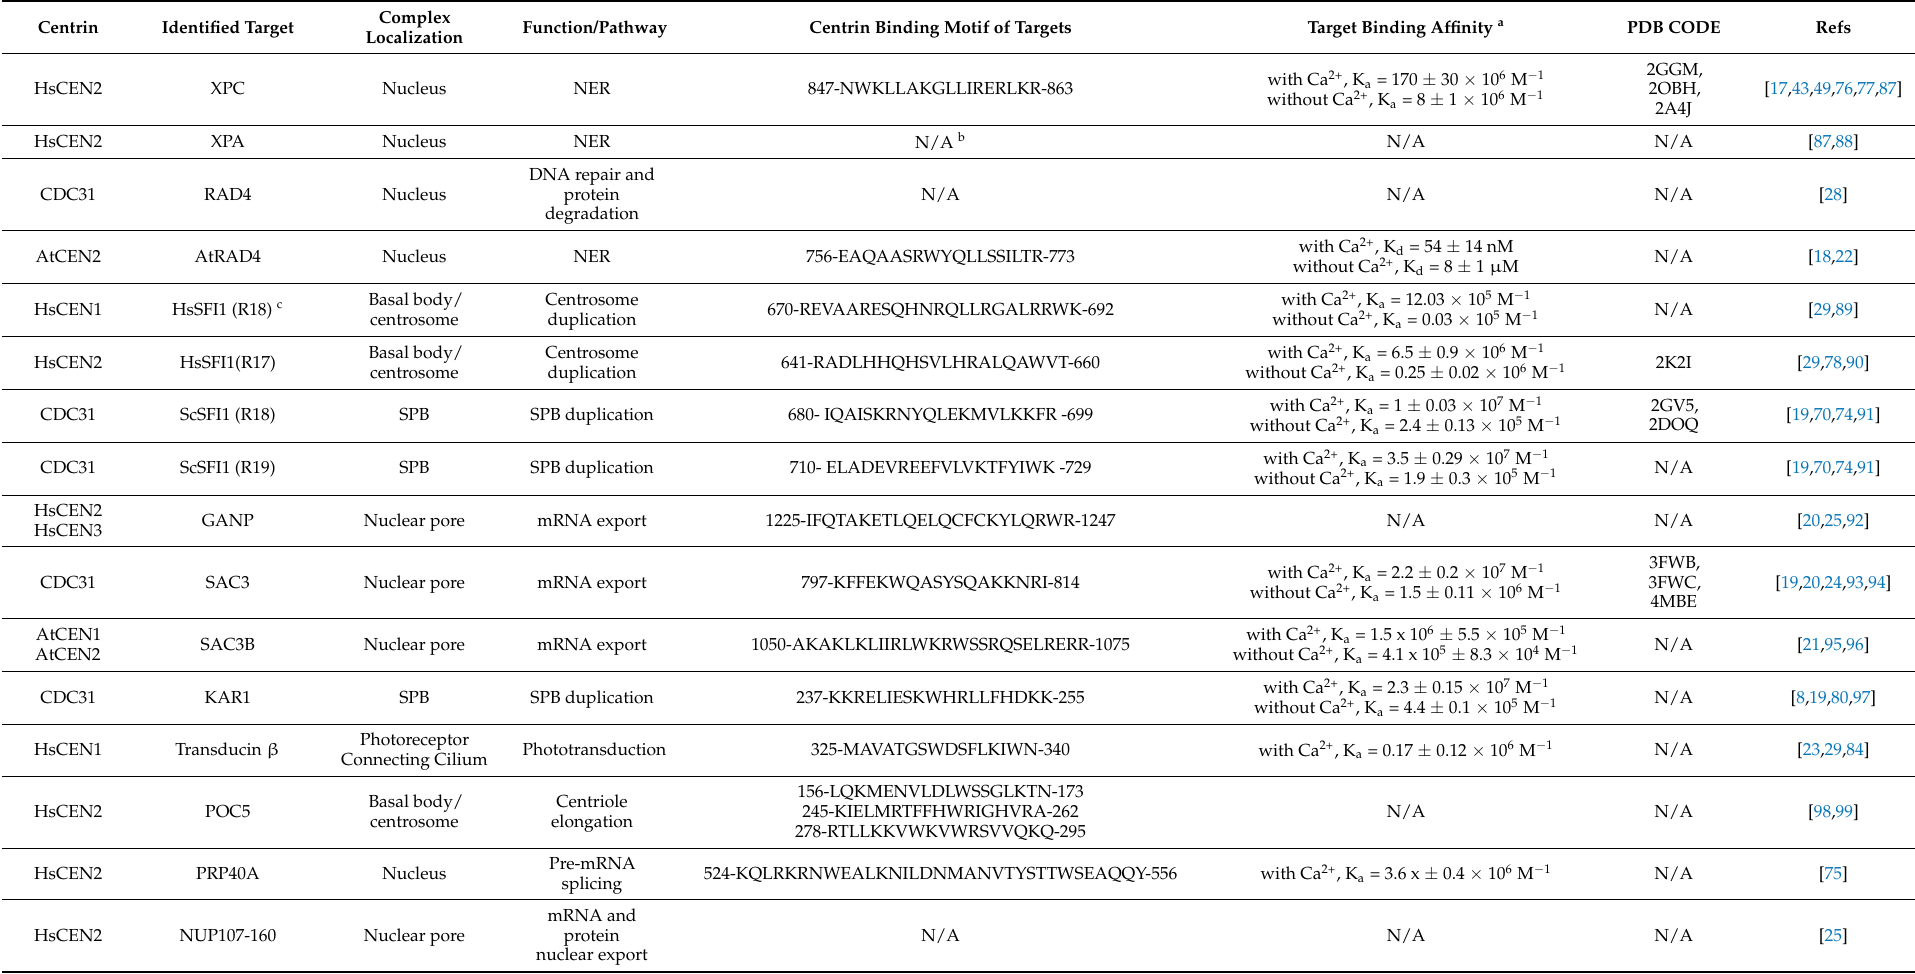
Table 2. Centrin